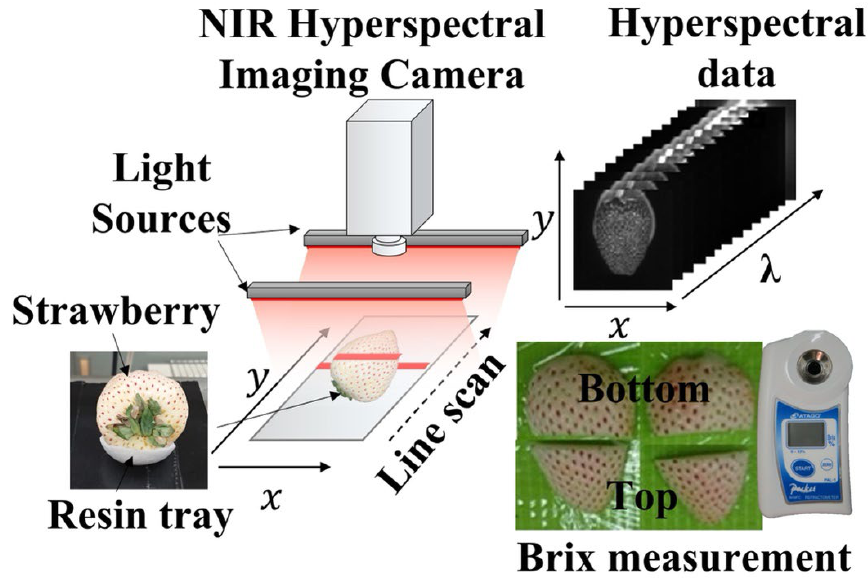
Figure 1. Near-infrared hyperspectral imaging (NIR-HSI) system and Brix measurement method used in this work.